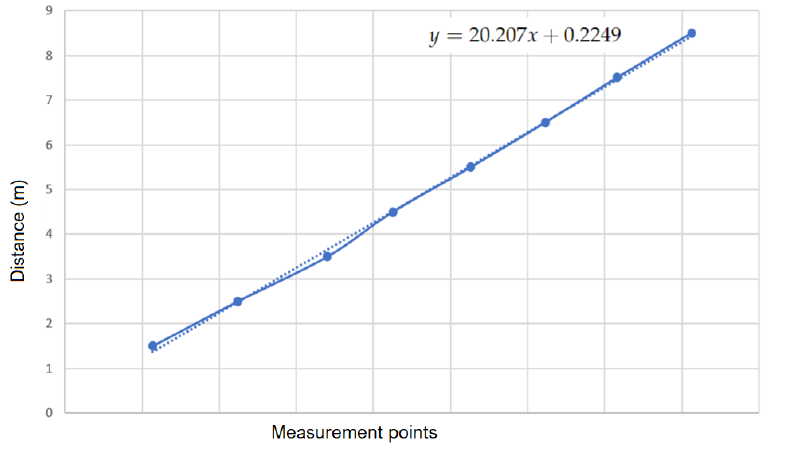
Figure 13. Determination of the real distance function two robots by using a